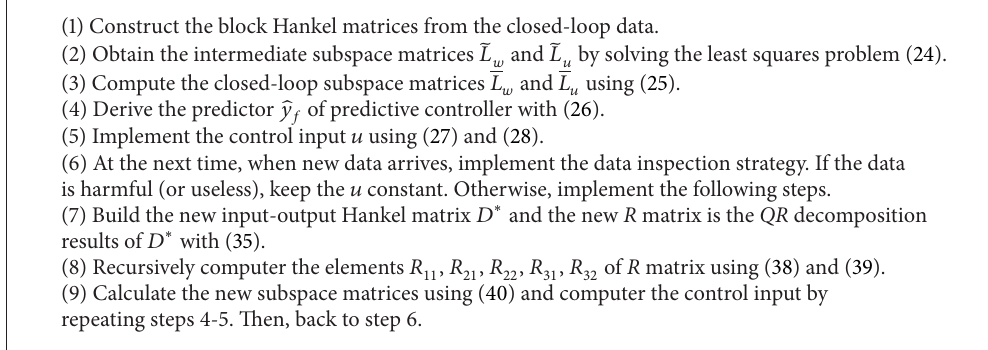
Algorithm 1: Summary of the proposed method.